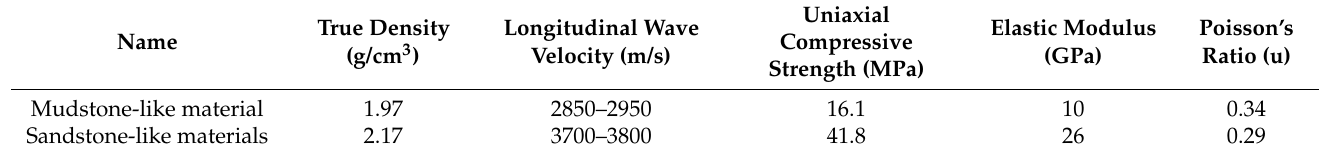
Figure 6. Stress–strain curves of mudstone-like samples.